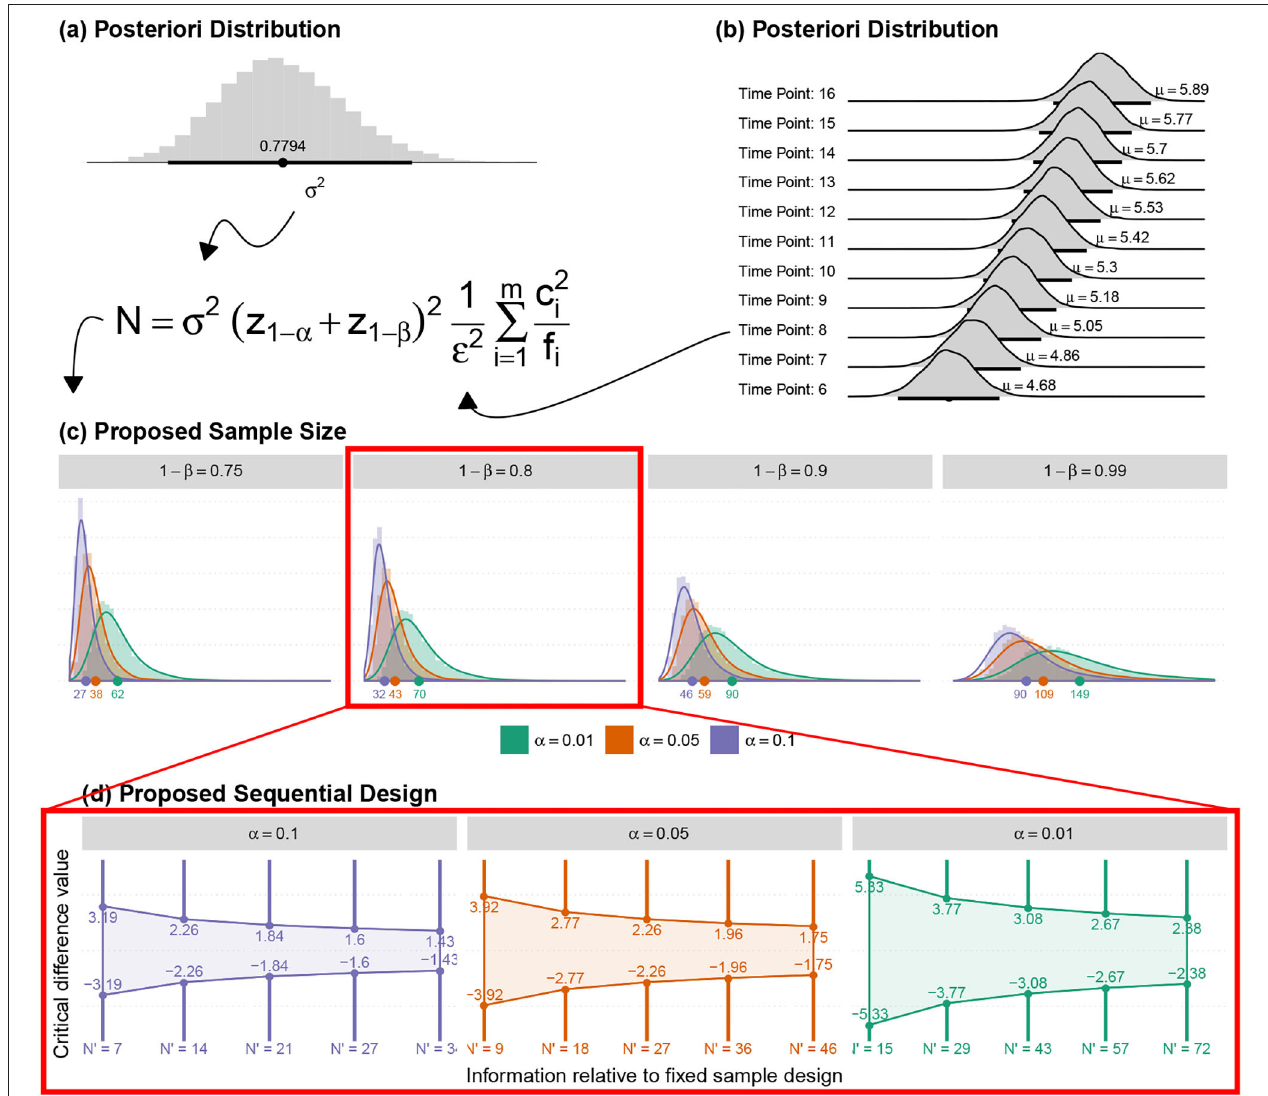
FIGURE 13 | (a) The posteriori distribution for the marginal variance of the adjusted model (just on Online block); (b) The posteriori distribution of the mean response for each online time point; (c) The posteriori distribution of the new sample sizes (for all other fixed amounts); and (d) The suggested sequential sampling